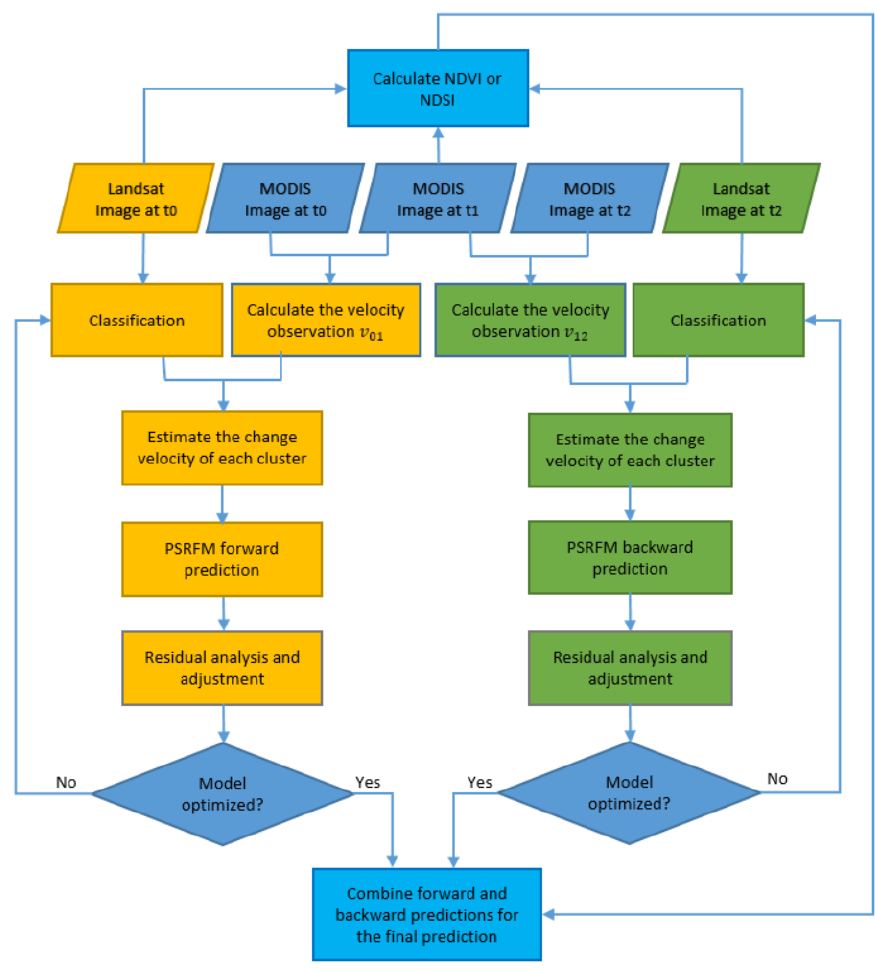
Figure 1. Processing flowchart of Prediction Smooth Reflectance Fusion Model (PSRFM).